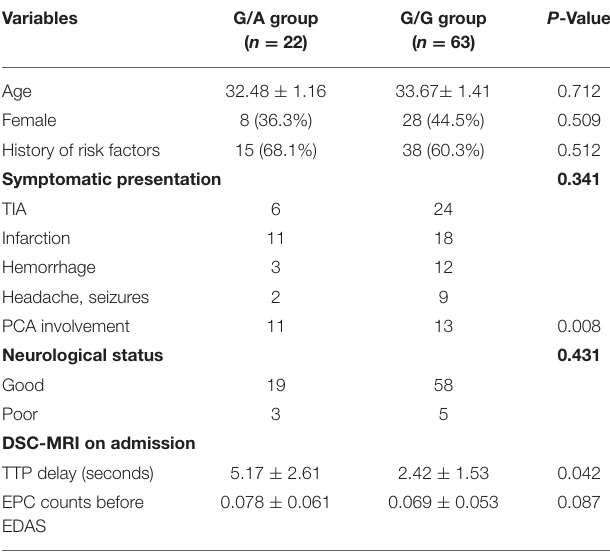
TABLE 4 | The comparison of baseline characteristics between the G/A group and the G/G group.